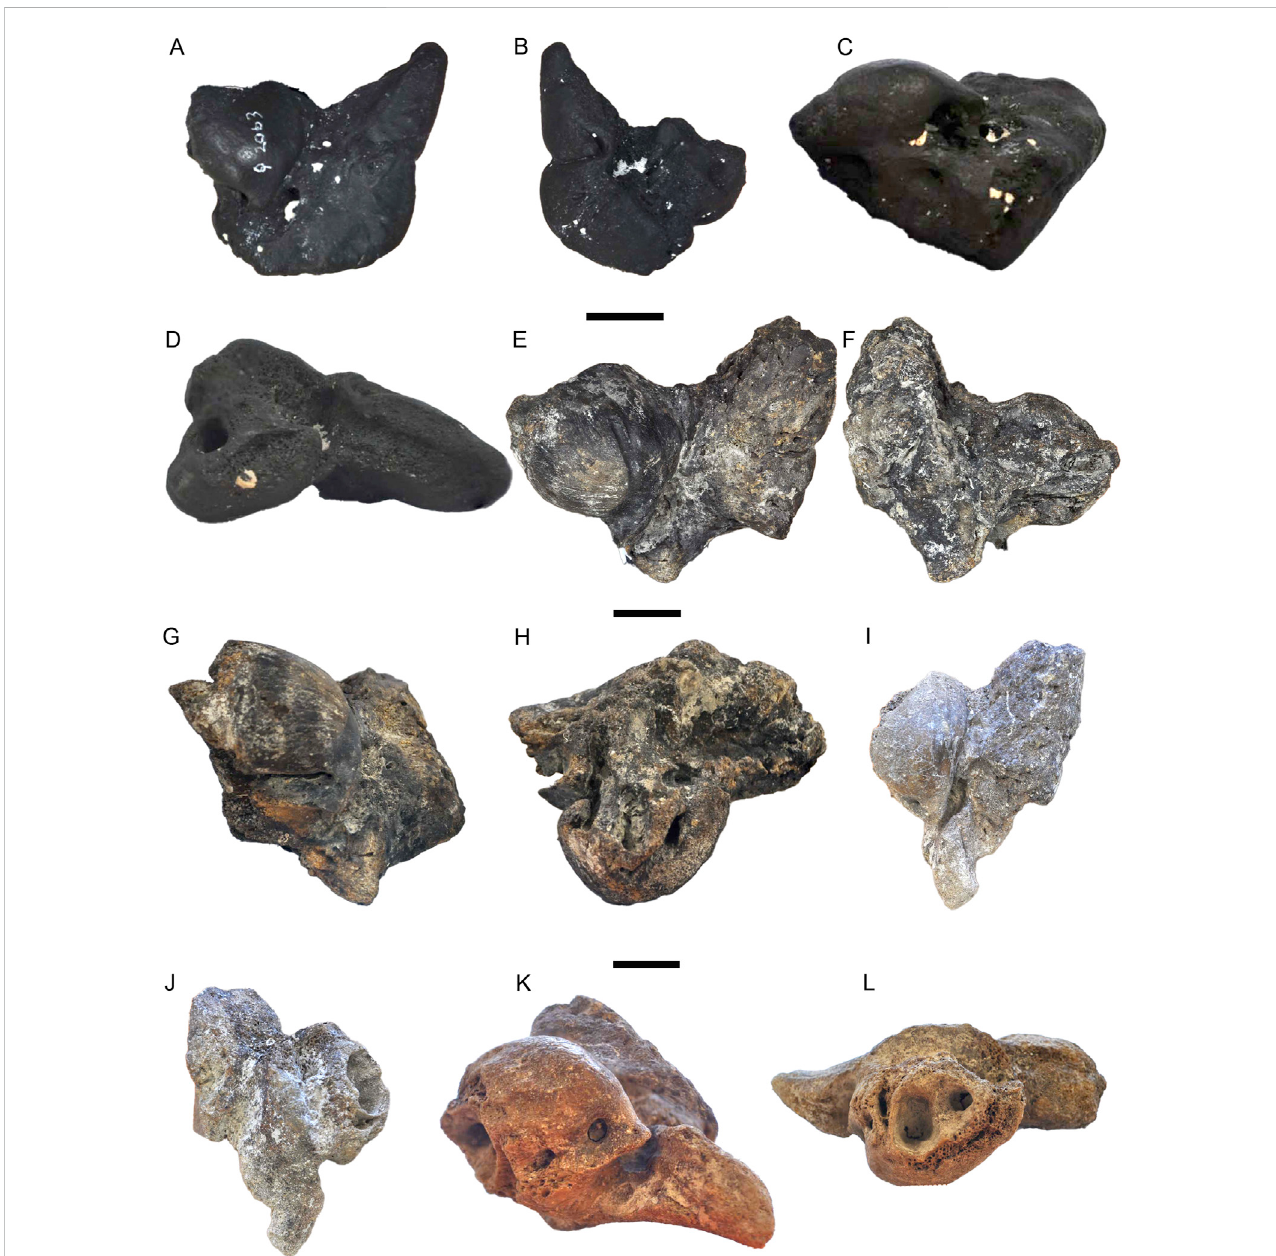
FIGURE 4 Fragilicetus sp. SAM-PQMT-2063 in (A) ventromedial, (B) lateral, (C) posterior, and (D) dorsal view, scale=2 cm. SAM-PQ-3084 in (E) medial, (F) lateral view, (G) posterior, and (H) dorsal view, scale=2 cm. Balaenopteridae indet. A, SAM-PQ-3094 in (I) ventromedial, (J) lateral, (K) posterodorsal, and (L) dorsal view, scale=2